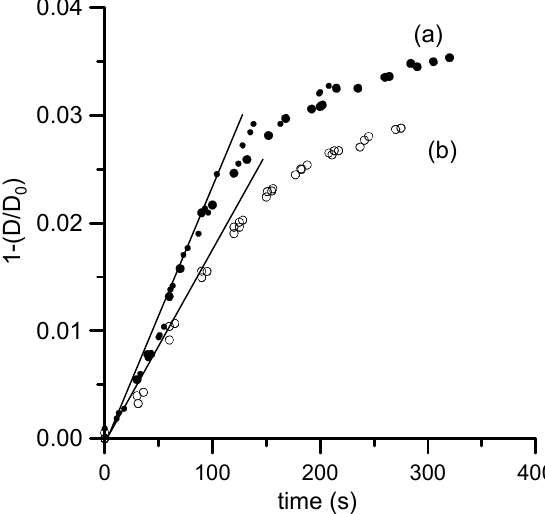
Figure 3. Representation of 1 − (D/D ) as a function of time for ethyleneglycoldimethacrylate 0 resins enclosing particles without added PMMA polymer ( a ) (small and large black symbols refer to duplicate experiments), and for a polymer dose of 4.32 mg PMMA polymer added to 0.5 g aerosil ( b ).